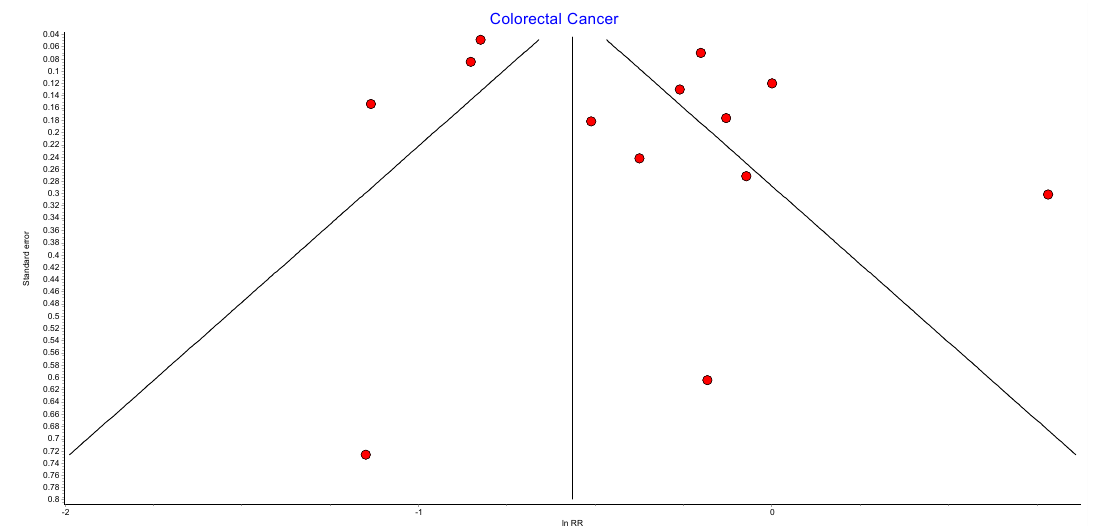
Figure A9. Colorectal cancer random effects model funnel plot.